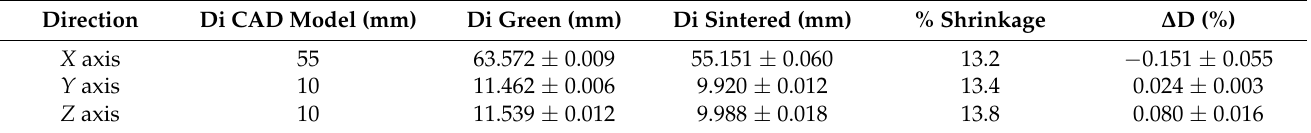
Table 2. Average values and deviations of the printed and sintered samples